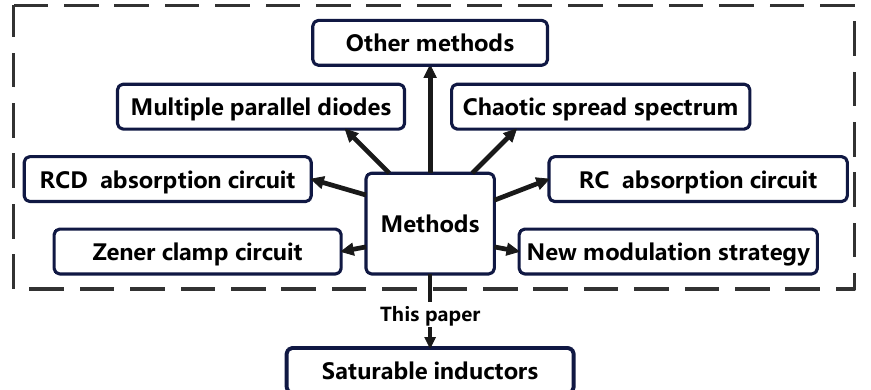
Figure 1. The methods used in resolving voltage oscillation and voltage spikes